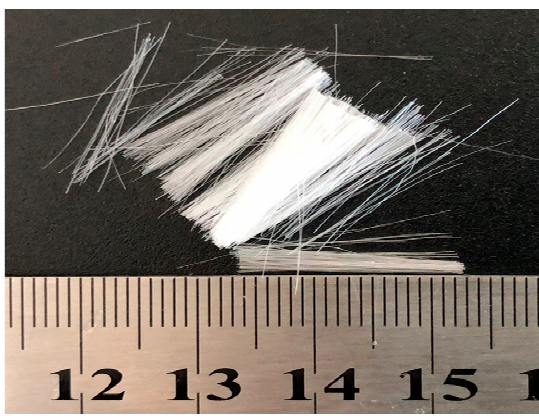
Table 3. The gradation compositions of the coarse aggregate.